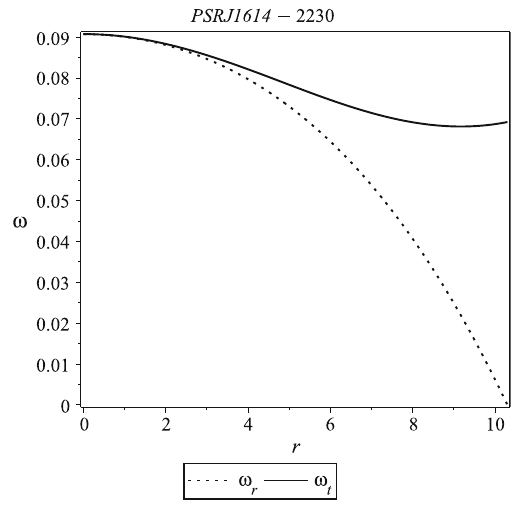
Fig. 7 Variation of the adiabatic indices Γ r and Γ t w.r.t. the radial coordinate r for the strange star candidate PSRJ 1614–2230